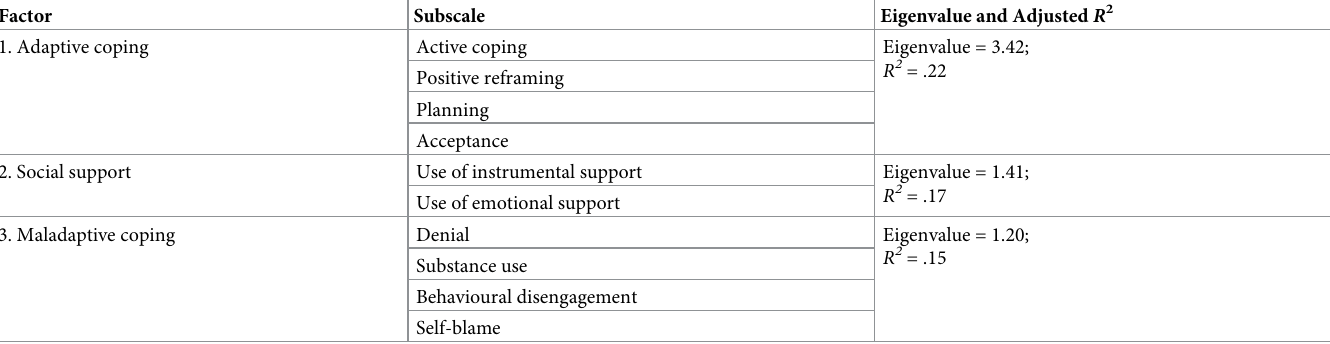
Table 1. Three factors for coping and subscales in each coping style.